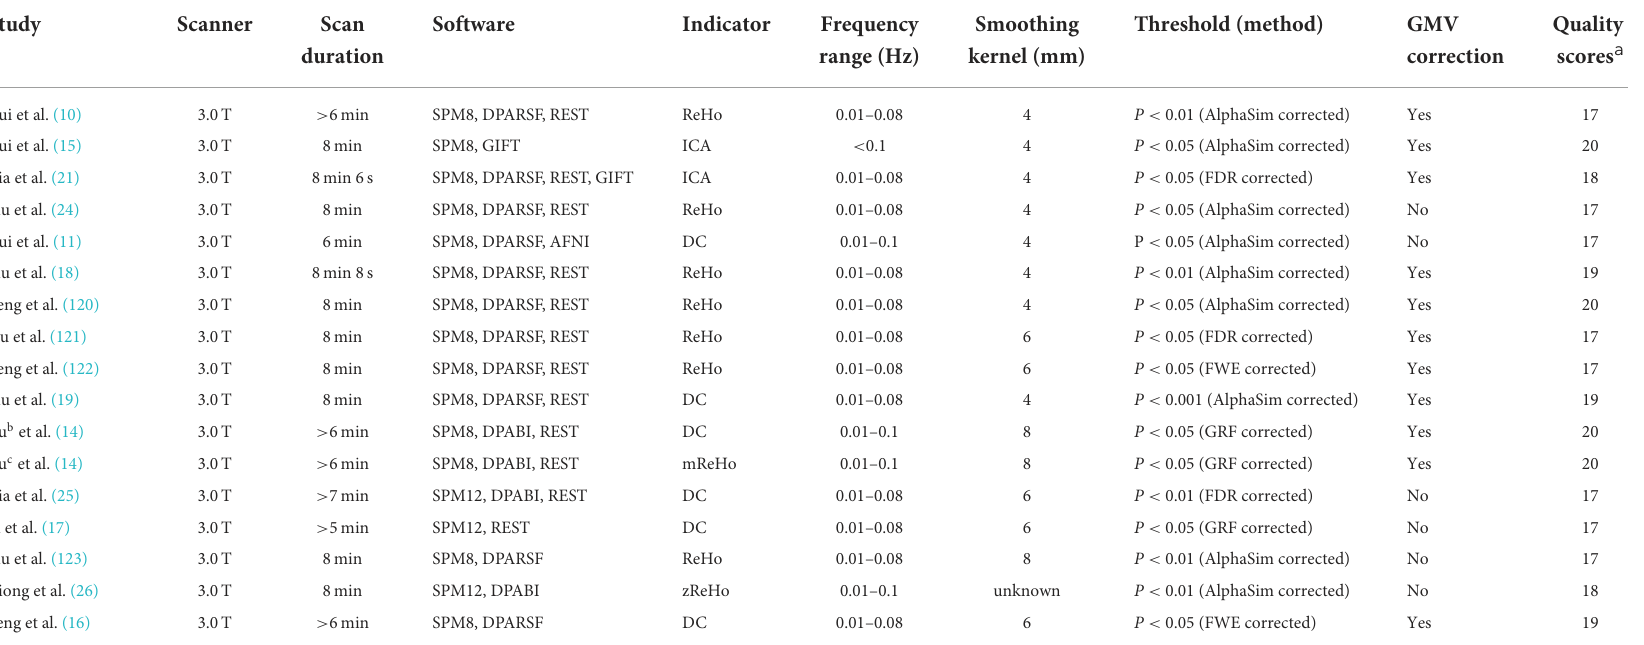
TABLE 2 Imaging characteristics of the studies included in the meta-analysis (group